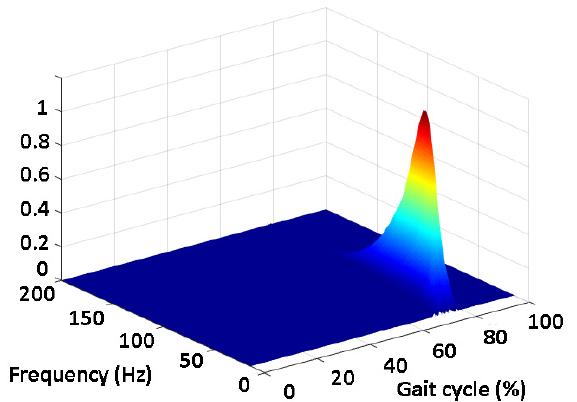
Figure 6. Three-dimensional color representation of CWT coscalogram between TA and GL for the same representative stride of subject five, depicted in Figure 5. The average co-contraction intervals achieved in each subject by the application of cycle, in Figure 7. The co-contractions detected in the stance and swing phase are high- lighted in blue and red, respectively.